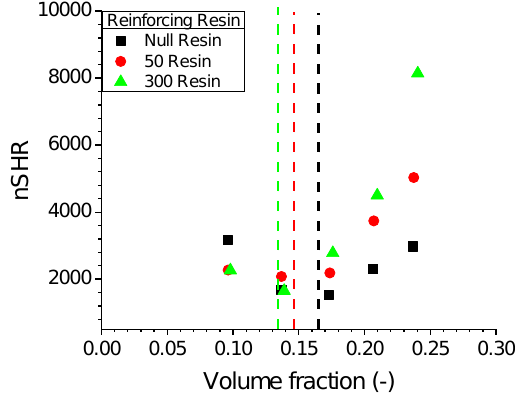
Figure 7. The nSHR values for the three resin concentrations in a N339-filled IR compound. Dashed lines indicate percolation threshold values obtained by RPA measurements. Note that the scaling is twice the scale in Figure